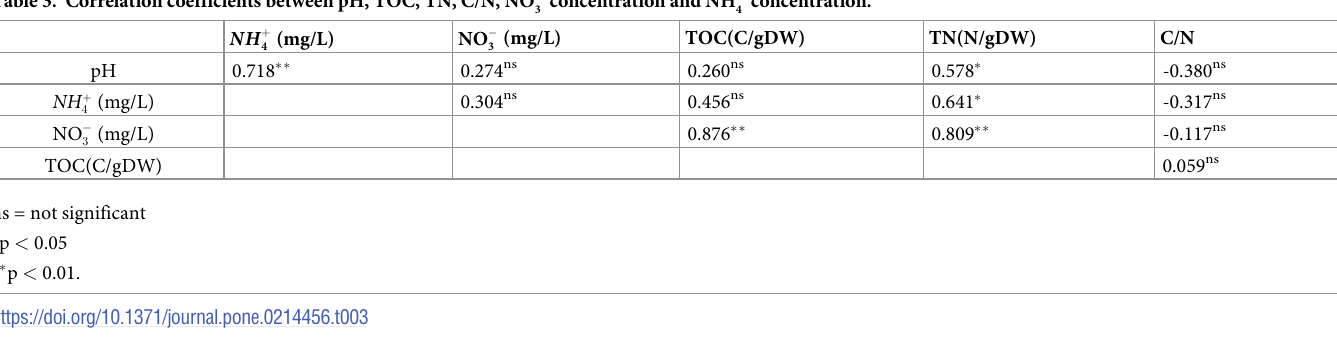
Table 3. Correlation coefficients between pH, TOC, TN, C/N, NO (cid:0)